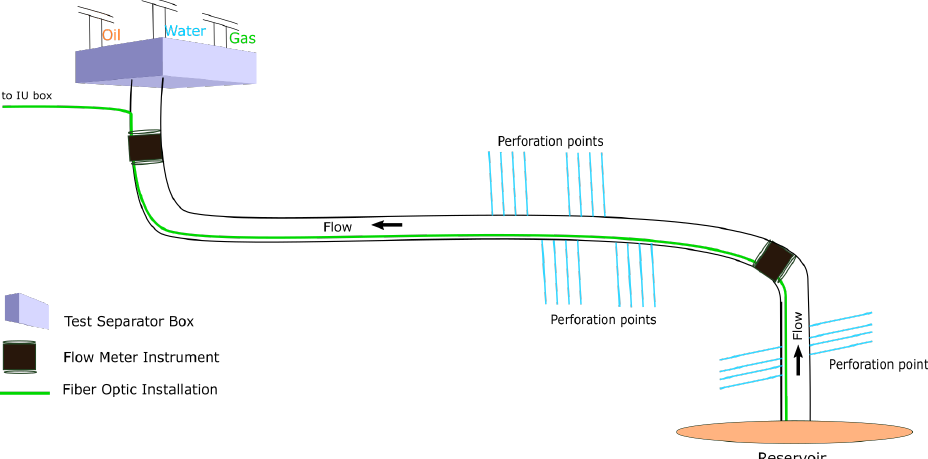
Figure 1. Current technologies to measure fluid content inside an oil pipeline, i.e., physical test separator, flow meter devices, and fiber optic technology. The test separator is the most accurate technology but it is intrusive and requires a redirection of the fluid flow, making it suboptimal for use in the production setting. The physical flow meter devices can provide real-time flow measurement but they are expensive, require complex installation procedures, and only provide point-based measurement. The fiber optic instrument as distributed virtual flow meter, however, can provide accurate distributed measurements with low-cost capital requirements while having the ability to provide distributed measurements. The distributed reading can help pinpoint the location of water breakthrough, leakage, and pressure drop, which can significantly increase production and reduce intervention costs of oil production